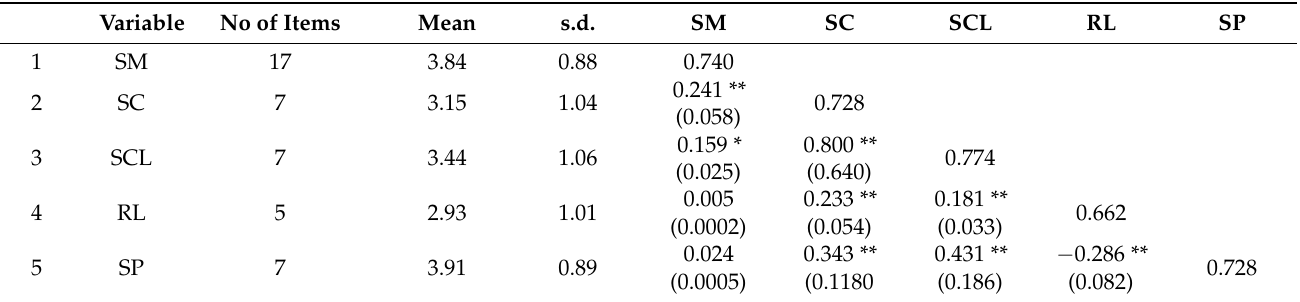
Table 2. Descriptive statistics and